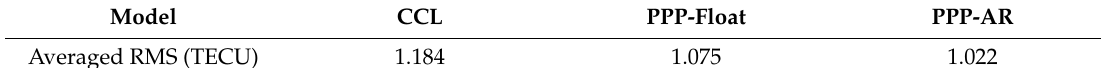
Figure 9. Difference distributions of the VTEC values of the CCL ( a ), PPP-float ( b ), and PPP-AR ( c ) methods compared to that of CODE GIM products on DOY 100, 2017. Table 6. Averaged RMS of VTEC differences for the CCL, PPP-float, and PPP-AR methods compared to CODE final GIM products.